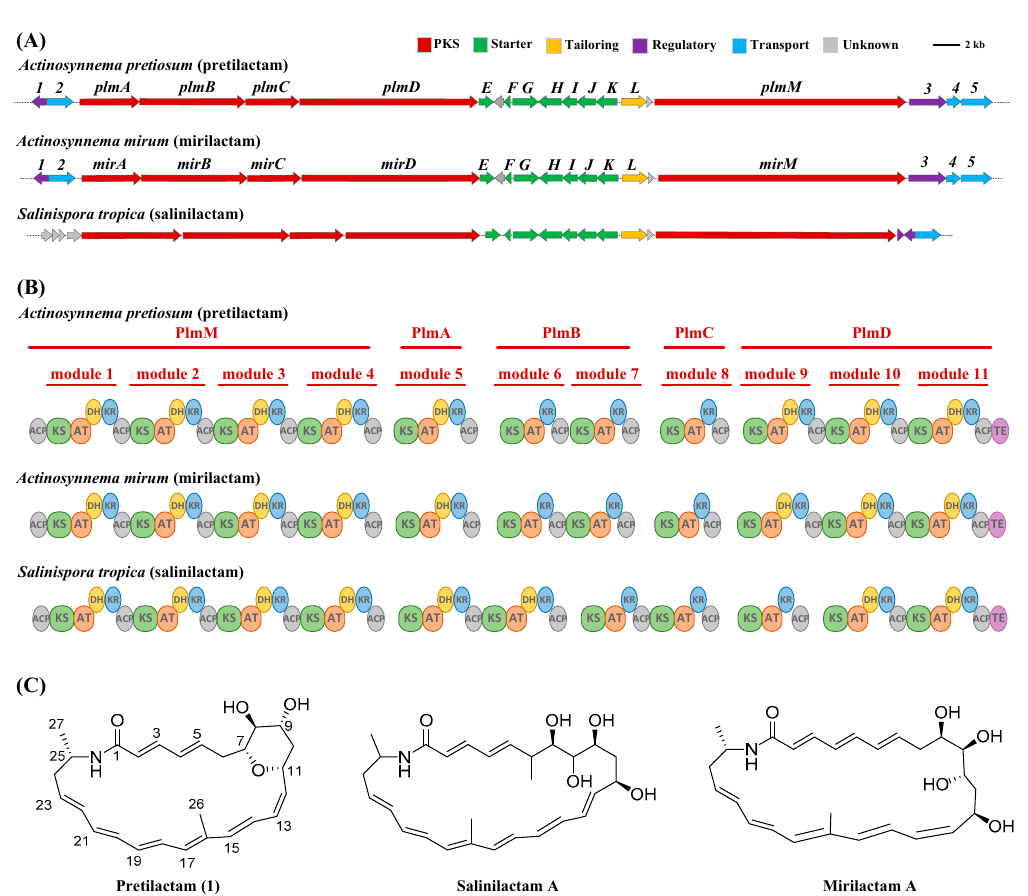
Figure 1. ( A ) The plm gene cluster for a putative polyene macrolactam (pretilactam, 1 ) from Actinosynnema pretiosum ATCC 31565 and its comparison with gene clusters for mirilactam from Actinosynnema mirum and salinilactam from Salinispora tropica . ( B ) Alignment of PKS domains for biosynthesis of the putative polyene macrolactam (pretilactam, 1 ), mirilactam and salinilactam. ACP, acyl carrier protein; AT, acyltransferase; DH, dehydrotase; KR, ketoreductase; KS, ketosynthase. ( C ) Structures of pretilactam ( 1 ), salinilactam A, and mirilactam A.